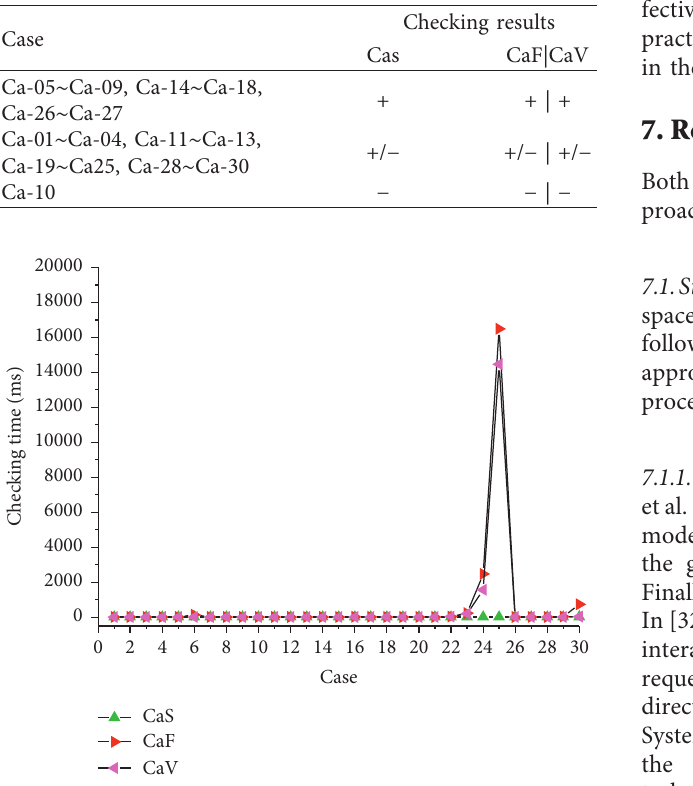
Figure 7: Checking time of three